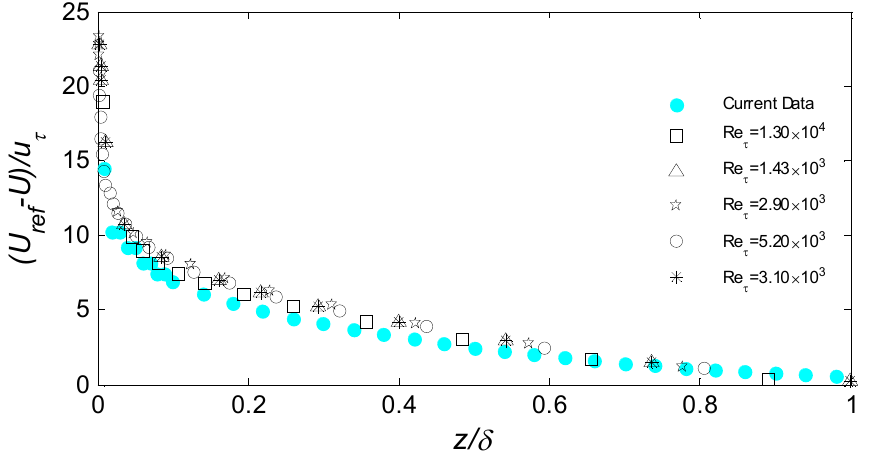
Figure 8. Mean velocity-defect profiles, normalized by friction velocity. The symbols used are the same as those used in Figure 6.